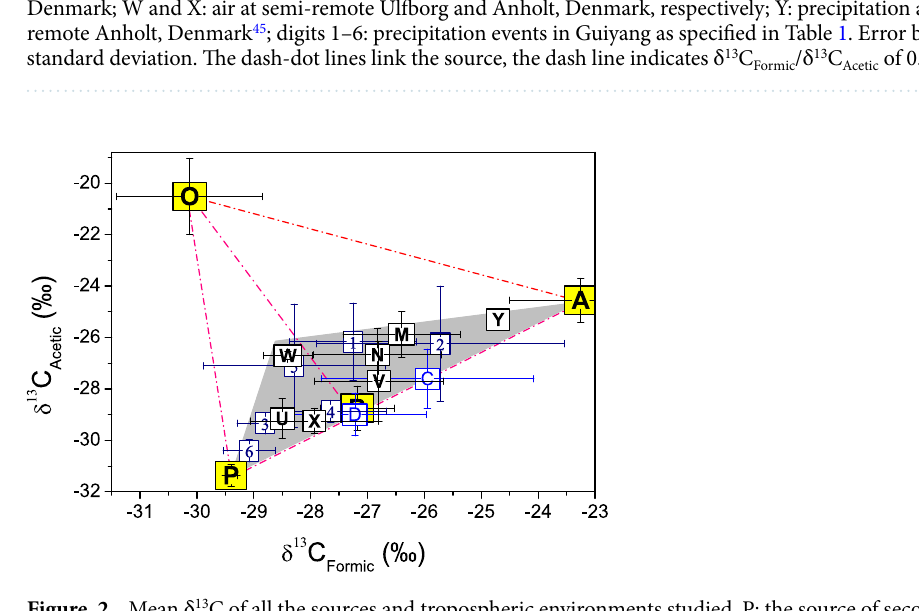
Figure. 2. Mean δ 13 C of all the sources and tropospheric environments studied. P: the source of secondary biogenic emission. The rest dots and lines are the same as in Fig. 1. The gray triangle indicates the range of the δ 13 C in the